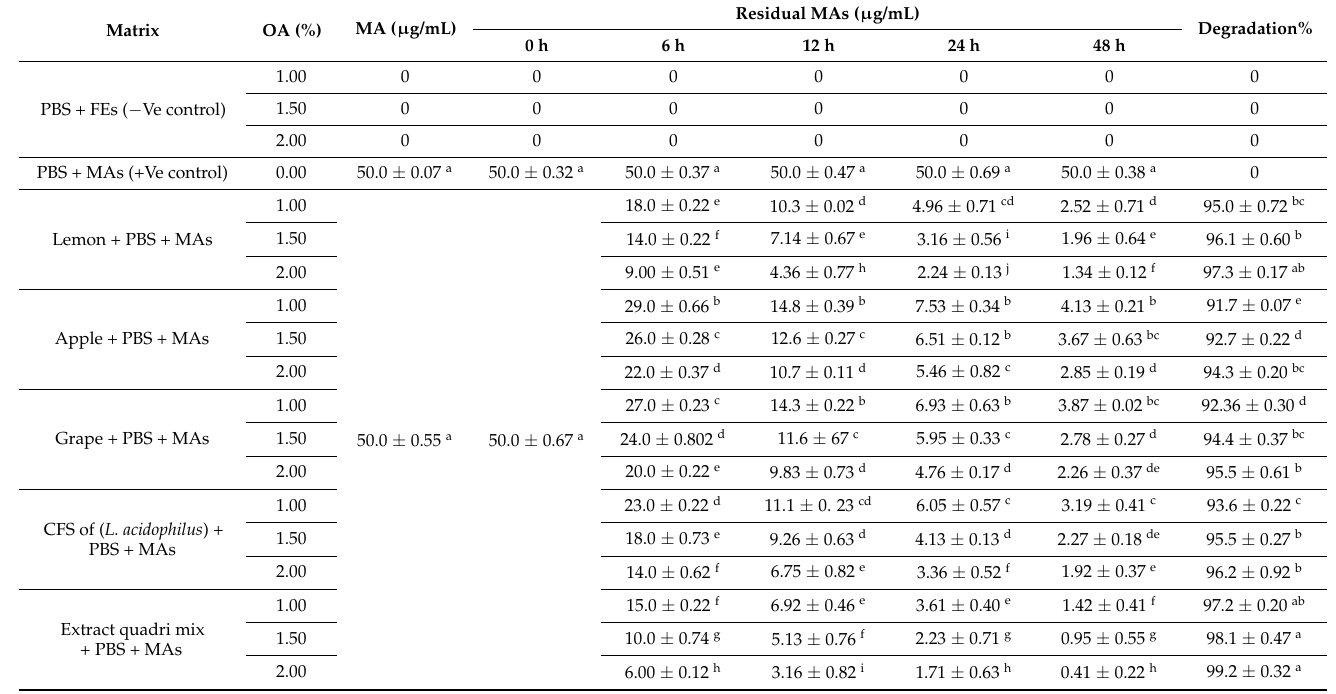
Table 2. Mycolic acid degradation efficiency by fruit extracts and cell-free supernatant of L. acidophilus in PBS